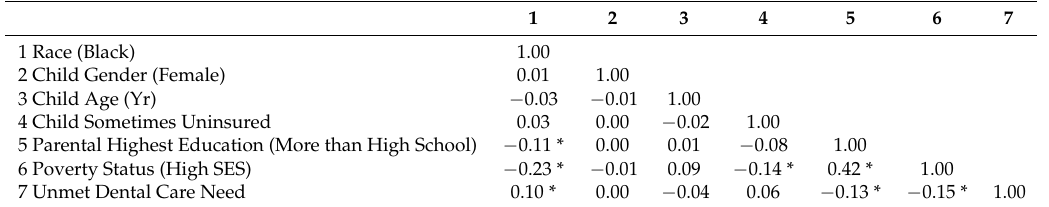
Table 2. Correlations in the pooled